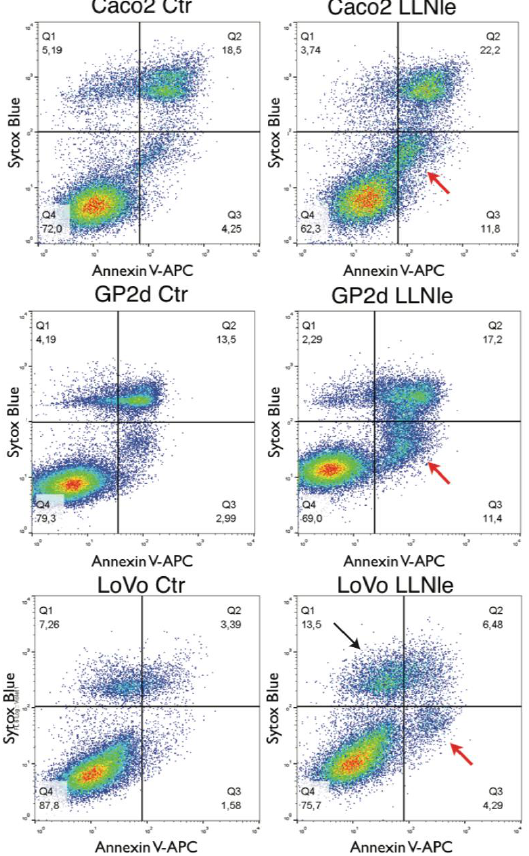
Figure 2. LLNLe induces apoptosis in Caco-2, GP2d and LoVo cell lines. Cells were treated for 72 h with LLNle (1.7, 1.4 and 0.6 µM LLNle for Caco-2, GP2d and LoVo, respectively) or with DMSO used as a control. Cells were labeled with both the DNA-specific and cell-impermeant sytox-blue, and annexin-V APC and fluorescence emissions were analyzed by FCM. Early apoptotic (annexin-V APC + and sytox-blue − ) cells are indicated by red arrows while necrotic cells (annexin-V APC − and sytox-blue + ) are indicated by a black